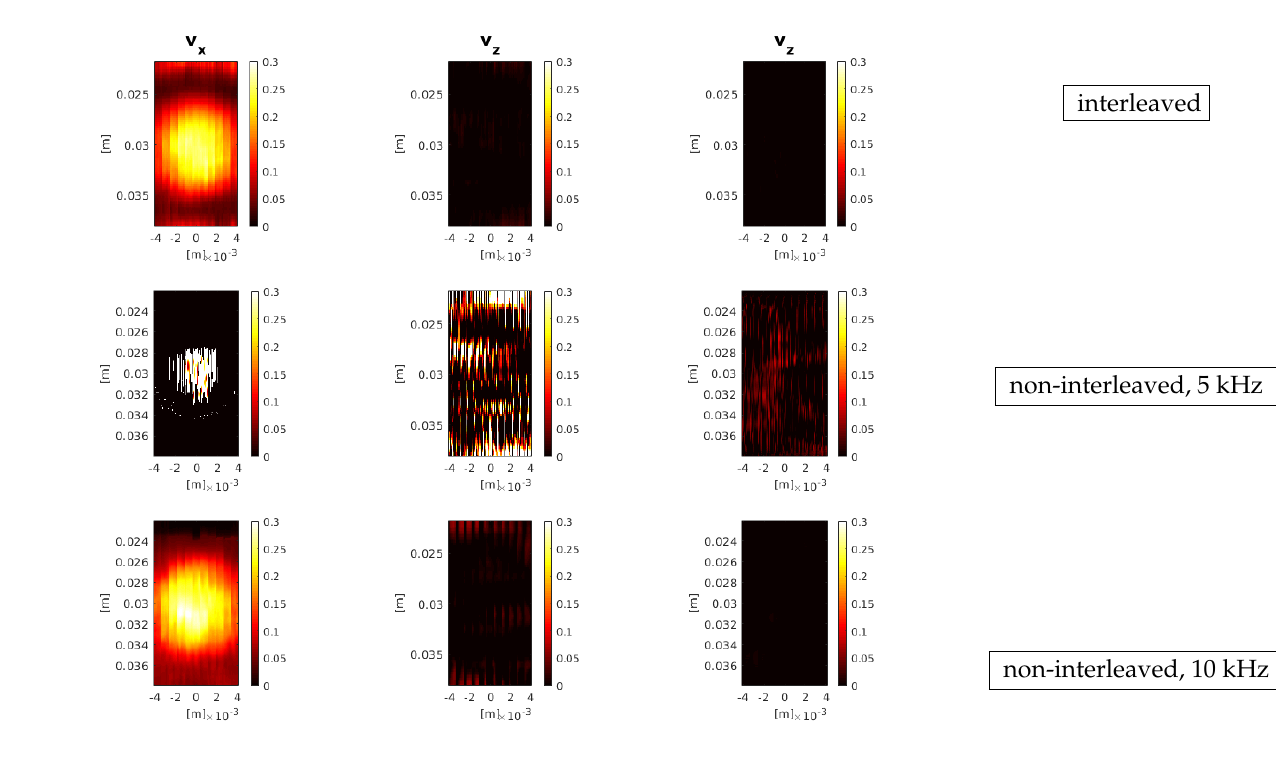
Figure 10. Cross planes for three representative methods. On the left side is v x , on the middle is v y , on the right is v z components of the flow. For all situations the beam-to-flow angle was 90 degrees and azimuth rotation angle is 0 degrees. The top row shows a cross planes from the interleaved sequence. The middle row shows cross planes from the non-interleaved sequence with f prf = 5 kHz, the bottom row shows cross planes from the non-interleaved sequence with f prf = 10